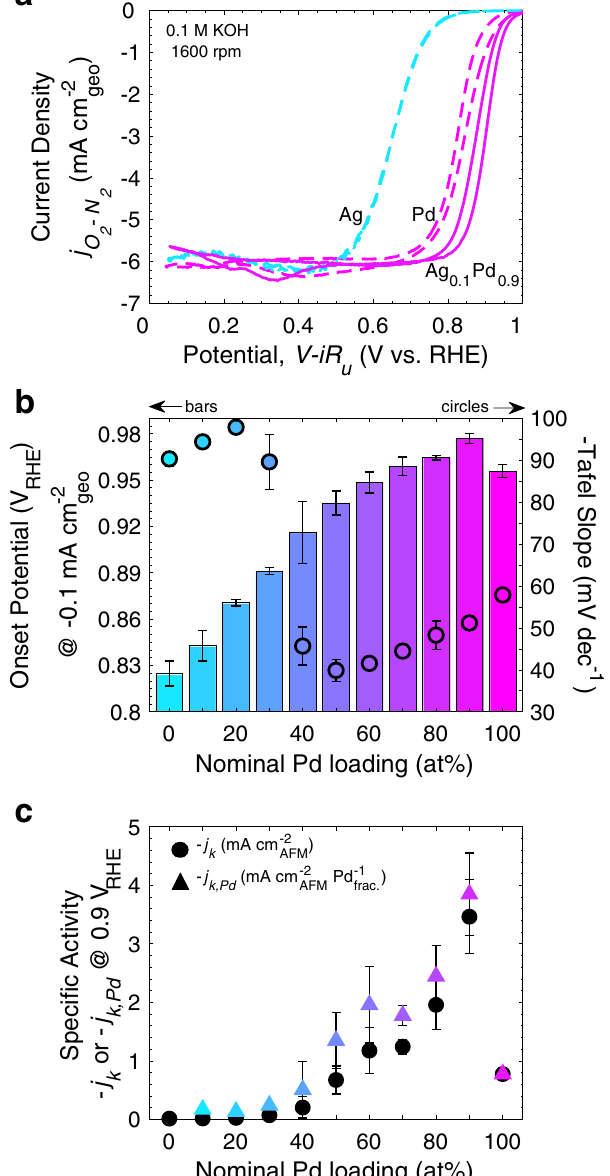
Fig. 2 Electrochemical ORR evaluation of Ag-Pd thin fi lm alloys. a Select ORR polarization curves for representative Ag, Pd, and Ag 0.1 Pd 0.9 thin fi lms. ), Tafel slope (circles), b Onset potential (bars) (potential at (cid:1) 0 : 1mAcm (cid:1) 2 geo and c speci fi c activity (kinetic current density at 0.9 V vs. RHE normalized by surface roughness determined by AFM) on an absolute (black circles) and Pd fraction-normalized (color-mapped triangles) bases for all Ag 1- x Pd x compositions investigated. Measurements were taken at 1600 rpm in O 2 - saturated 0.1 M KOH, have non-ORR current subtracted (from CVs in N 2 - purged electrolyte), and are corrected for the uncompensated electrolyte series resistance. All data points are representative of the average value from the cathodic and anodic scan of the third CV cycle and error bars are the standard deviation from measurements with separate samples (see Supplementary Figs. 7, 11, 12 and Supplementary Table 3 for representative ORR CV curves, kinetic current densities at 0.9 and 0.8 V vs. RHE, representative Tafel plots, and tabulated data,